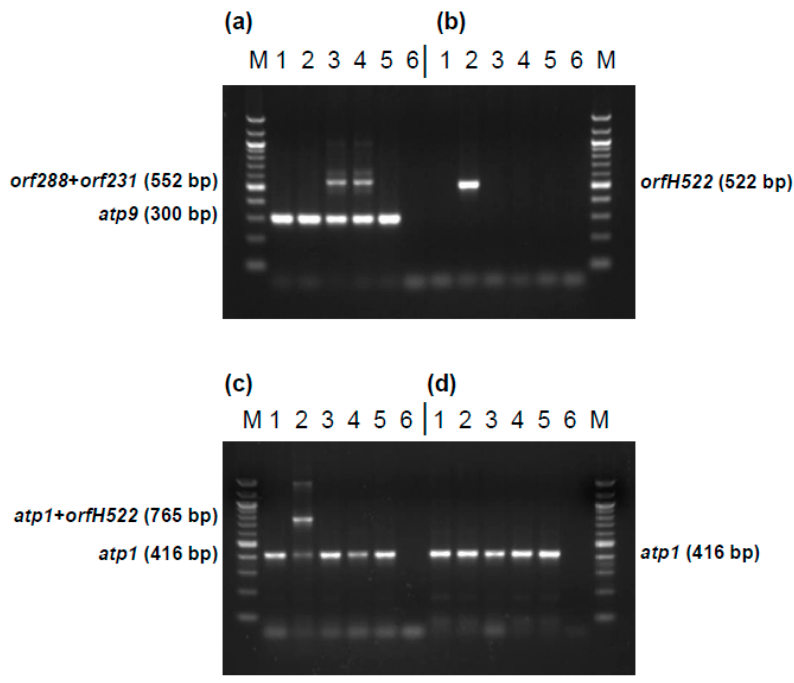
Figure 9. Development of markers specific for CMS PET1, CMS PET2 and the fertile, normal cytoplasm in sunflower. ( a ) Marker HRO_ATP9-PET2 using primer combination orf300_for/orf300_rev; ( b ) Marker HRO_PET1 using primers orfH522_for/orfH522_rev; ( c ) Marker HRO_ATP1-PET1 using primer combination M_atp1_for/M_atp1_rev/orfH522_rev; ( d ) Marker HRO_ATP1 using primer combination M_atp1_for/M_atp1_rev; Lanes: 1, HA342 (male fertile, normal cytoplasm); 2, CMS PET1 × HA342 (male sterile); 3, CMS PET2 × IH51 (fertility restored F1-hybrid); 4, CMS PET2 × RHA265 (male sterile); 5, RHA265 (restorer line, male fertile, normal cytoplasm); 6, PCR negative control; M, 100 bp marker.